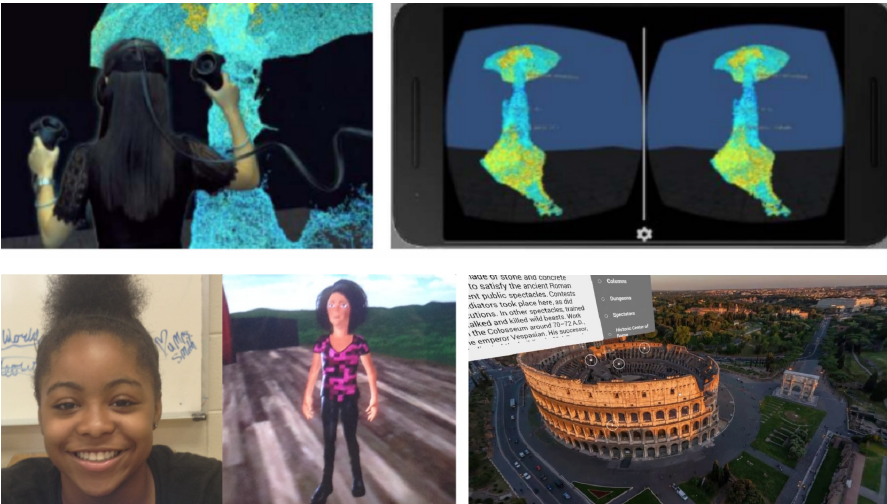
Figure 5. Screenshots of VR applications for general education: Top : Thrihnukar experience in the HTC Vive [42]. Bottom : left—Participant of VEnvI with her customised character [110]; right—Colosseum VR Tour by Google Expeditions